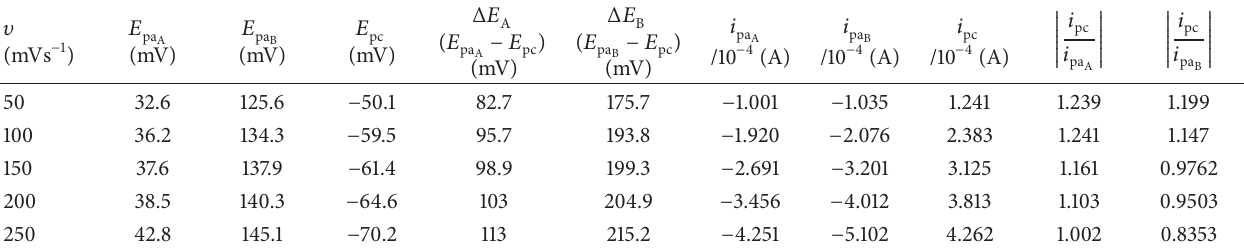
Table 1: Variation of the voltammetric parameters as a function of the potential scan rate ( 𝜐 ) corresponding to the CVs shown in Figure 4. 𝜐 (mVs − 1